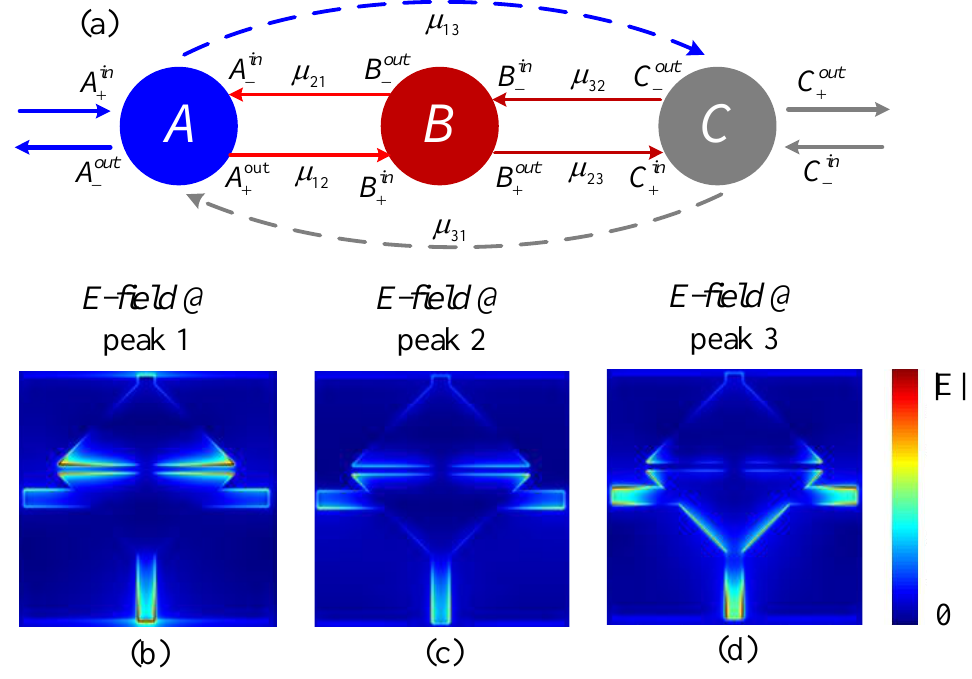
Figure 3. ( a ) Schematic diagram of CMT, A corresponds to Bright Mode 1, B corresponds to Bright Mode 2, and C corresponds to Dark Mode, here µ mn = 10 4 cm − 2 v − 1 s − 1 . ( b – d ) The corresponding electric field distribution at three transmission peaks.